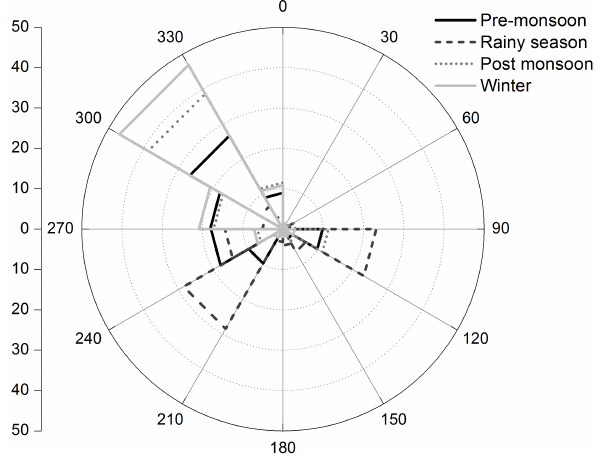
Fig. 3. Trajectory occurrence-% as a function of the main 30 ◦ sector during different seasons.